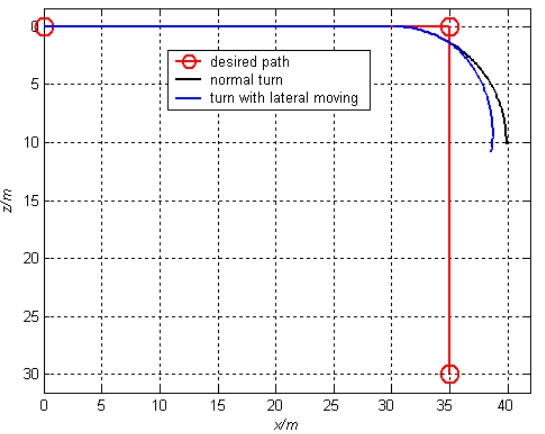
Figure 18. Turning at the corner.